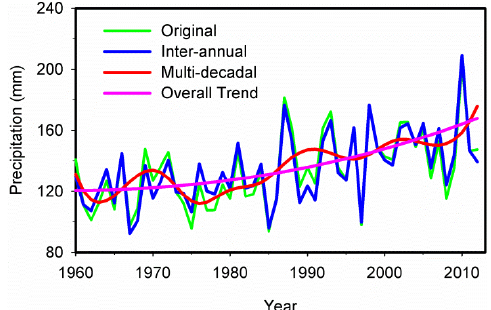
Figure 6. The average annual precipitation time series and its inter-annual trend, multi-decadal trend and overall adaptive trend in Xinjiang.